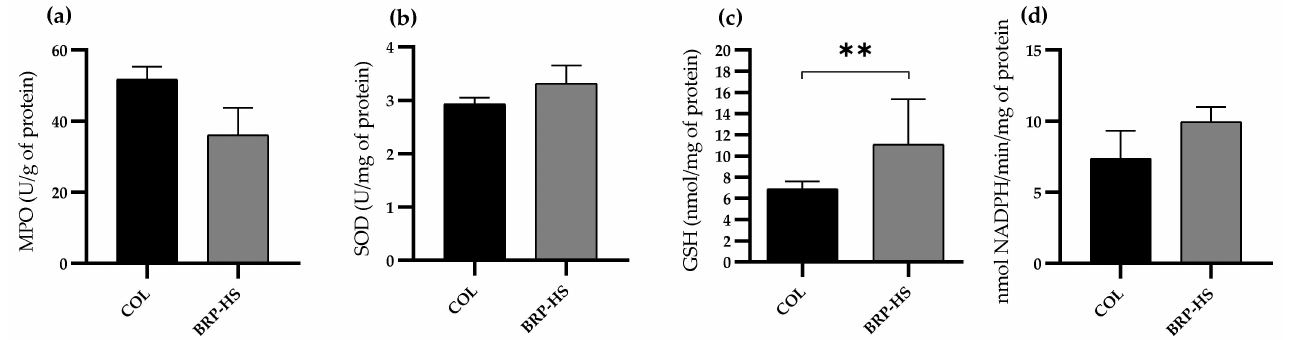
Figure 14. Concentration of MPO ( a ), SOD ( b ), GSH ( c ) and GR ( d ) on skin wound samples from groups COL and BRP-HS treated over 14 days. Statistical significance between groups according to unpaired t test with ** p < 0.01 ( n = 6). No significance between groups in MPO, SOD and GR